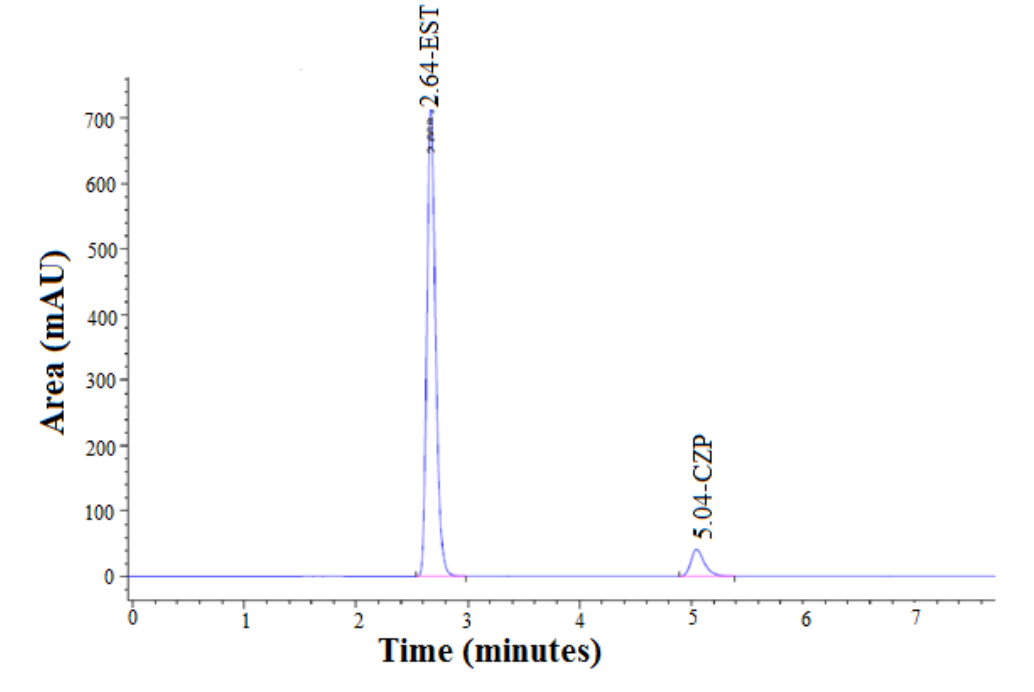
Figure 11. Representative high-performance liquid chromatography (HPLC) chromatograms of standard EST (R t = 2.64 min) and CZP (R t = 5.04 min).